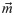
(a) Classification tree which predicts, for a given injury vector m→, whether the injured dynamics will fall into a “paralyzed” fixed point in the upper or lower part of the plane (as in Fig 5). The cross-validation accuracy exceeds 85%. (b) Cross-validation error as a function of minimum leaf size. We choose a minimum leaf size of 40. (c) The neurons implicated as most important for determining functional outcome of the injury, given these behavioral classes. A classification tree and implicated subset of neurons could be generated via this method for any feature of injured dynamics which we wished to explore.